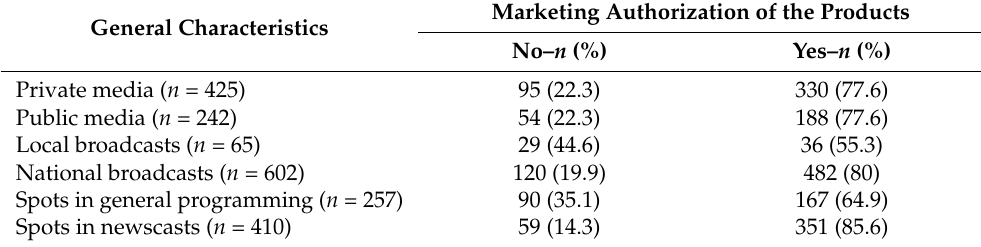
Table 1. General characteristics of monitored communication media, according to the health registra- tion or notification of its